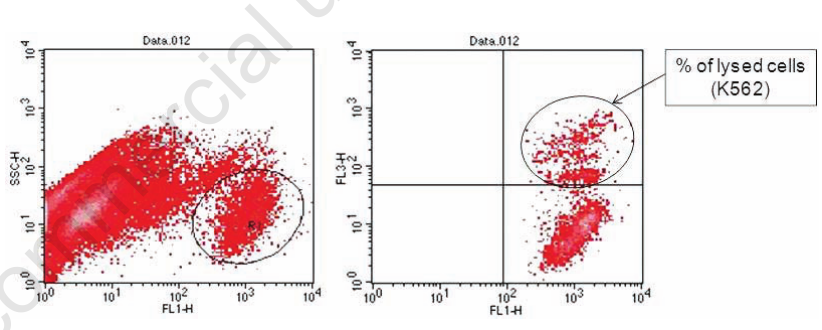
Figure 2. Flow cytometric analysis of target cells using FL-1 versus FL-3 dot plots gated on R1. The right panel showed the DiO-labeled targets after exposure to effectors. The upper right quadrant represents double positive events (targets). The lower right quadrant represents DiO-positive events (intact targets).